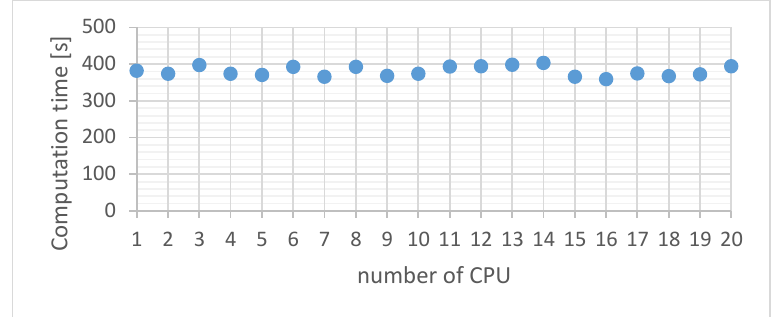
Figure 11. Computation time per CPU to compute the economic impact resulting from a flood with a return period of 20 years with the FLIAT tool.